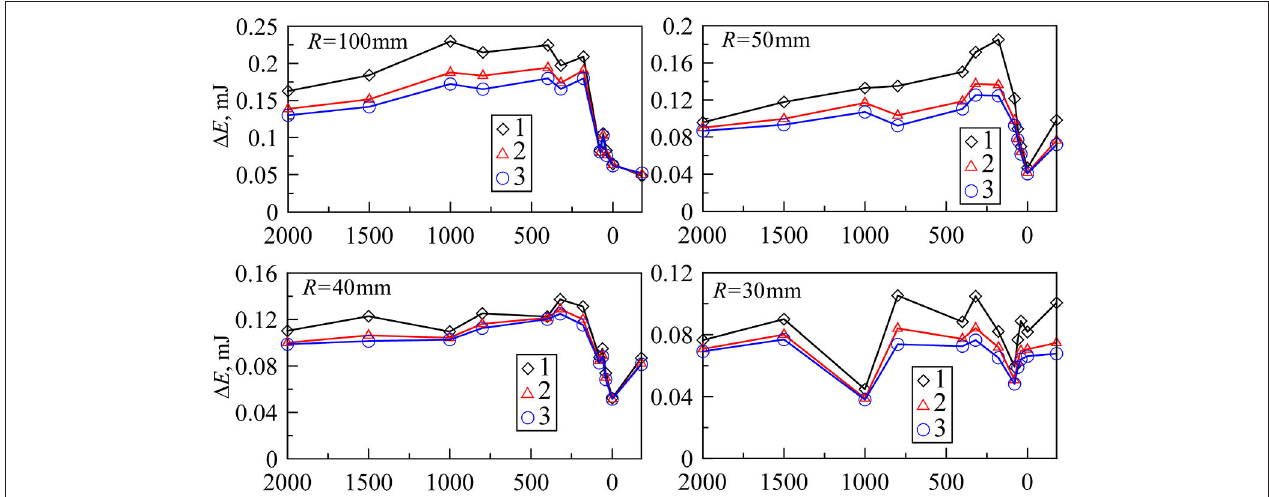
FIGURE 8 | Dependencies of calculated C ( q ) for all indenters and roughness. The curves with different colors correspond to the curves in Figure 5 with the same colors and line styles (solid and dashed lines). The solid red lines in all figures correspond to the situation with smallest roughness P2000.